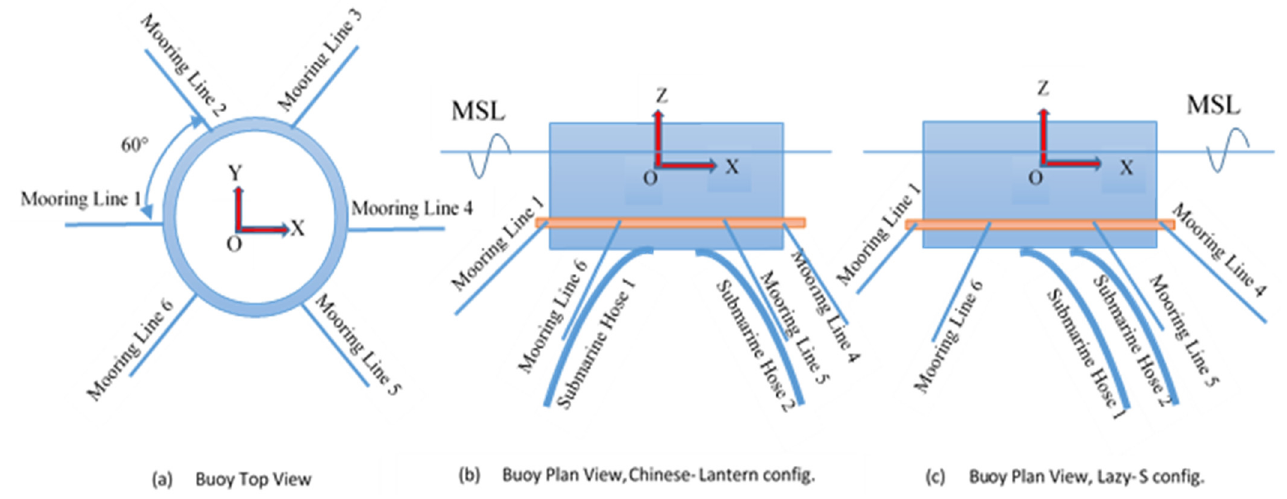
Figure 7. Schematic for the moorings on the buoy showing.